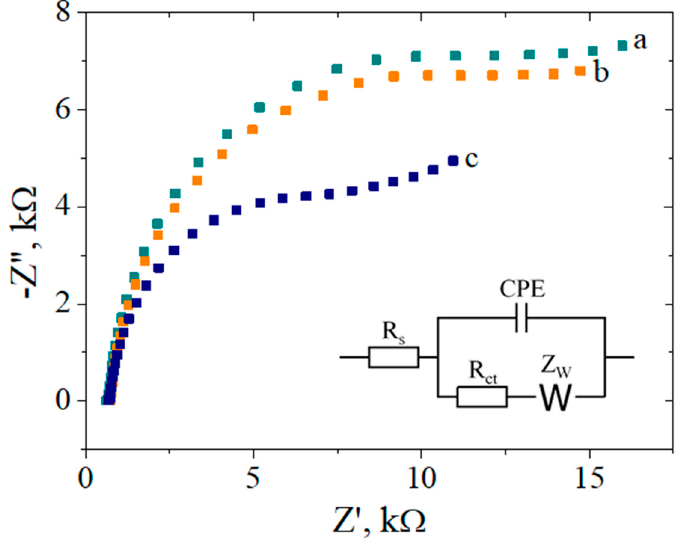
Figure 6. EIS Nyquist plot recorded in 1 mM [Fe(CN) 6 ] 3 − /4 − , 0.1M KCl, for the Ar–COOH/RGO–mod-